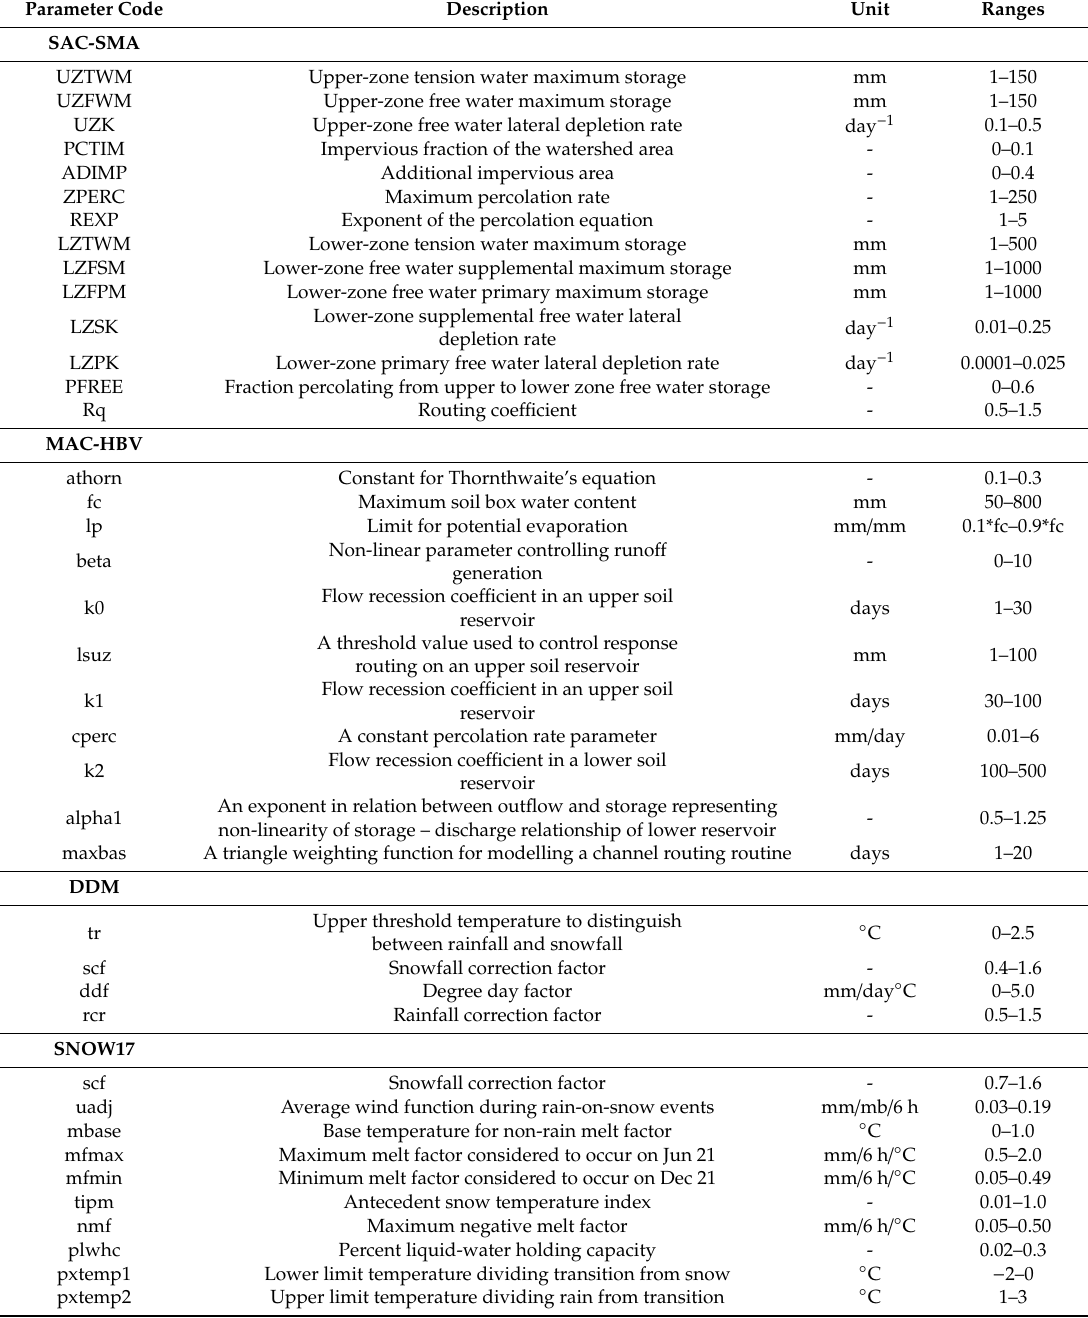
Table 1. Calibrated model parameters and their descriptions, units, and ranges